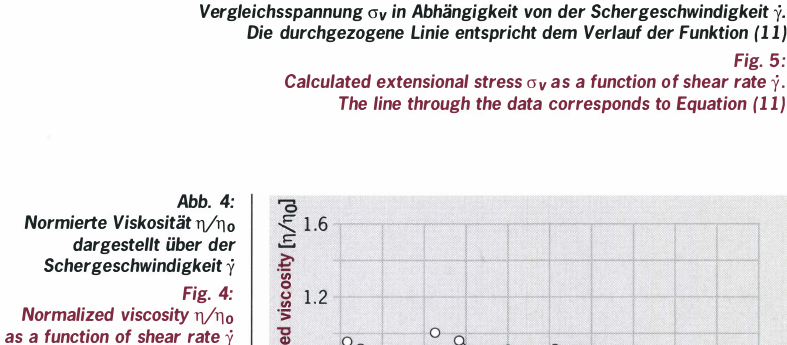
Normalized viscosity ll111 o as a function of shear rate y